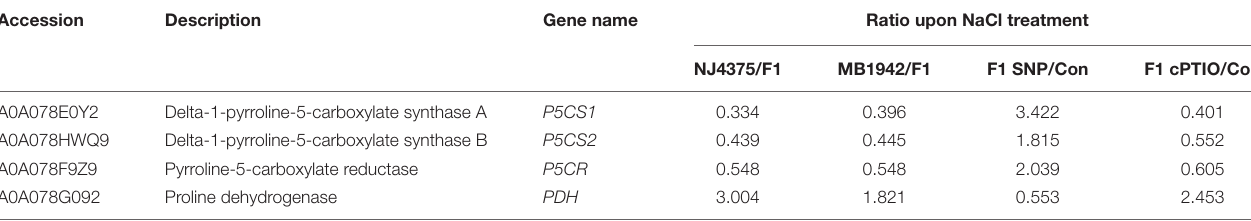
TABLE 3 | List of proline metabolism proteins in three seedling leaves of B. napus materials in response to salt stress for 3 days with or without SNP or cPTIO pre-treatment for 12 h.